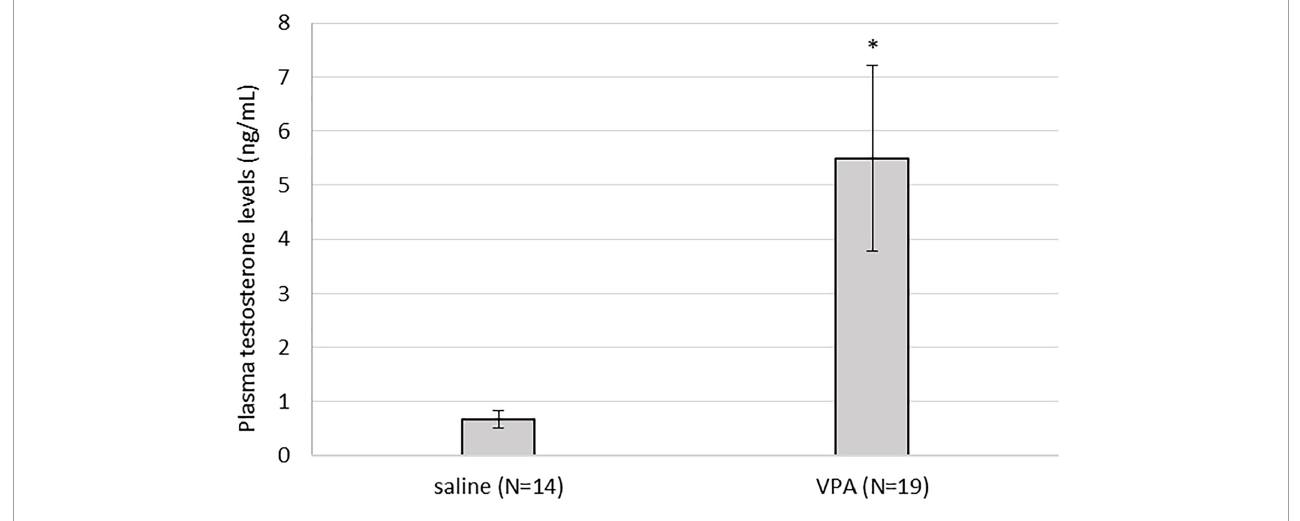
FIGURE6 Plasma testosterone levels were statistically significantly higher in valproate (VPA) males compared to control males ( p ∗ < 0.05).